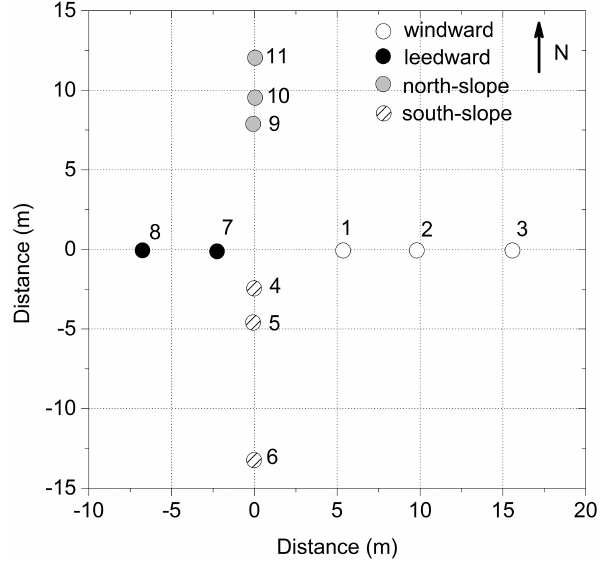
Figure 1. Schematic of measurement positions (11) distributed on four slopes (windward, leeward, north- and south-facing slope) over a fixed sand dune as well as plot positions and labels.